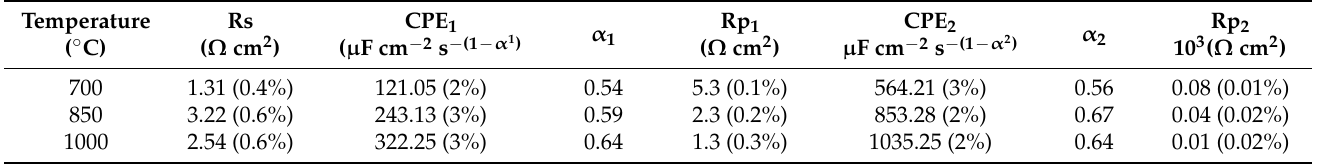
Table 5. ValuesoftheelectrochemicalparametersoftheequivalentelectricalcircuitforBi 3 La 1 Ti 3 O 12 coatings. Temperature